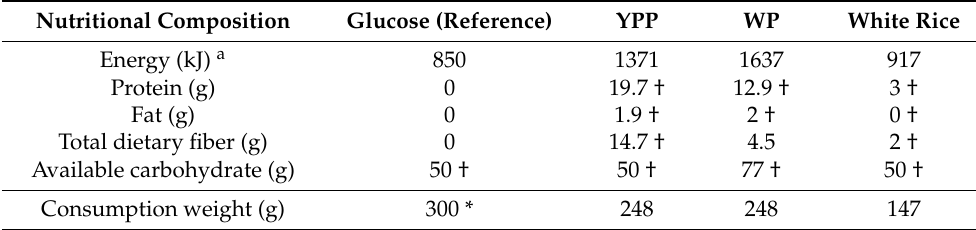
Table 5. Nutritional composition of test foods.